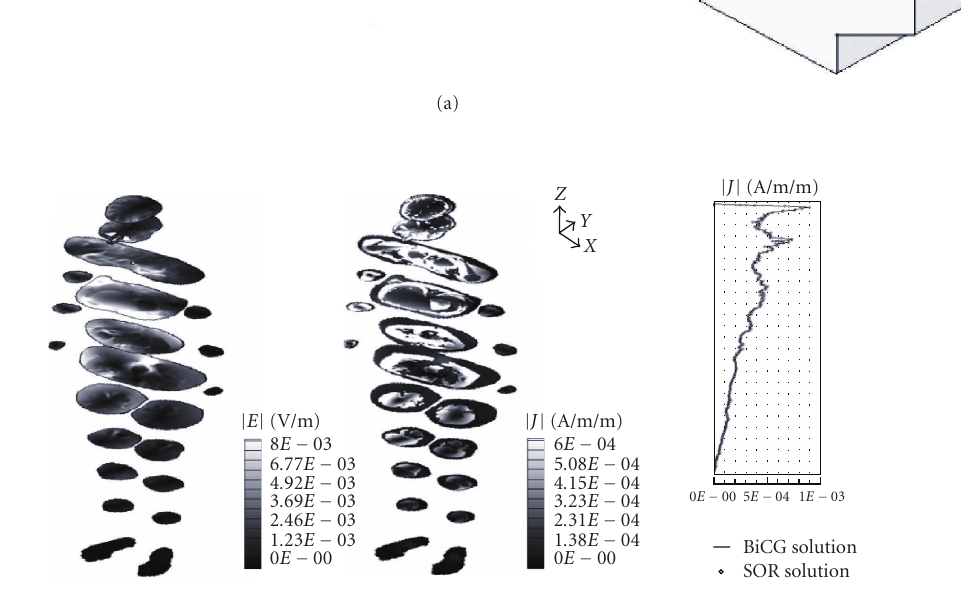
Figure 4: (a) Typical body posture near the imager where gradient coils are assumed to be pulsed as described in the text, (b) axial slices illustrating the spatial distributions of induced electric field and current density and (c) comparison of the average current density along the superior-inferior axis between the QSFD-BiCG and QSFD-SOR methods indicating less than 1% of relative